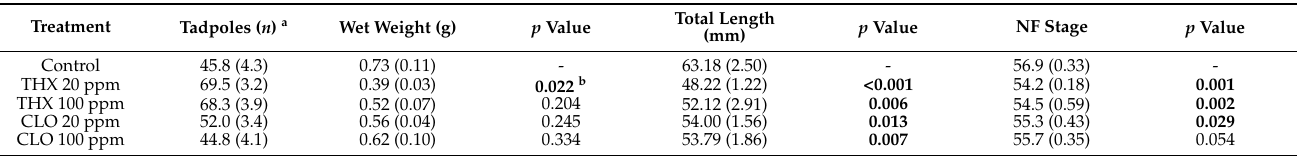
Table 3. Morphometrics (SE) of Xenopus laevis tadpoles at the end of 44 days of exposure to thiamethoxam (THX), clothianidin (CLO), or in neonicotinoid-free media in four replicate vivaria per treatment.